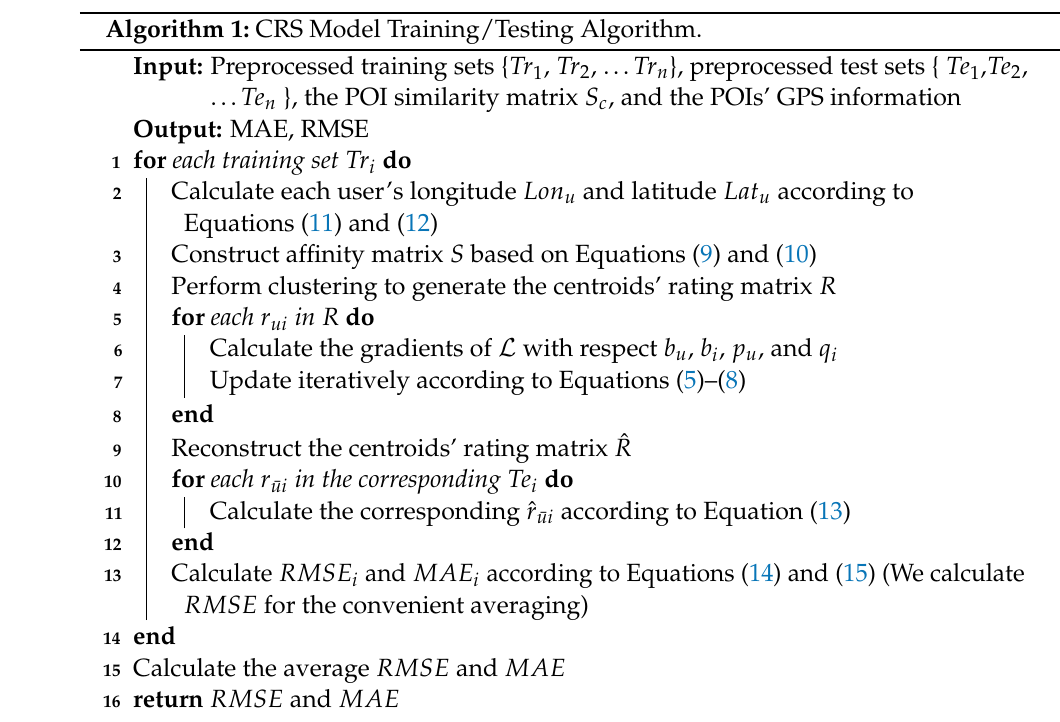
Algorithm 1: CRS Model Training/Testing